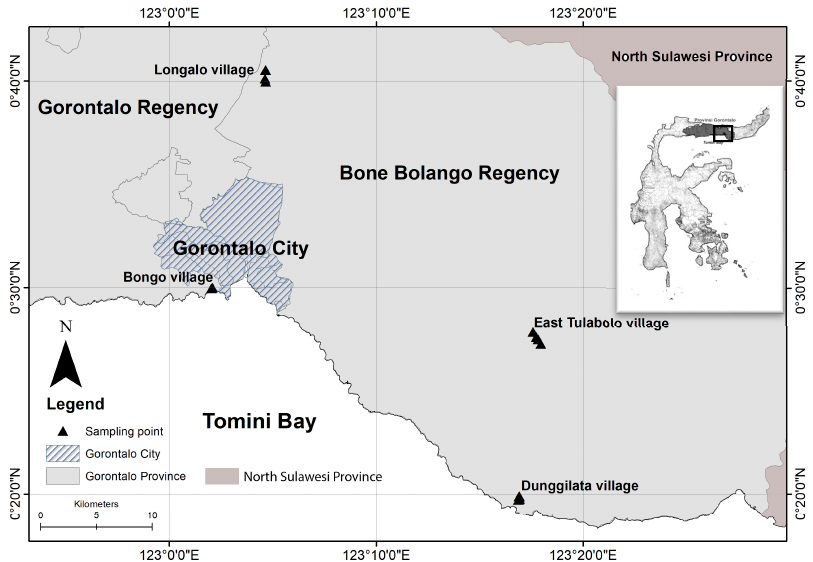
Figure 1. Location of sample points from four areas in two Regencies (triangle sign), in Gorontalo Province, Indonesia, wherein three areas located in Bone Bolango Regency (East Tulabolo, Dunggilata, and Longalo villages) and one area located in Gorontalo Regency (Bongo village).